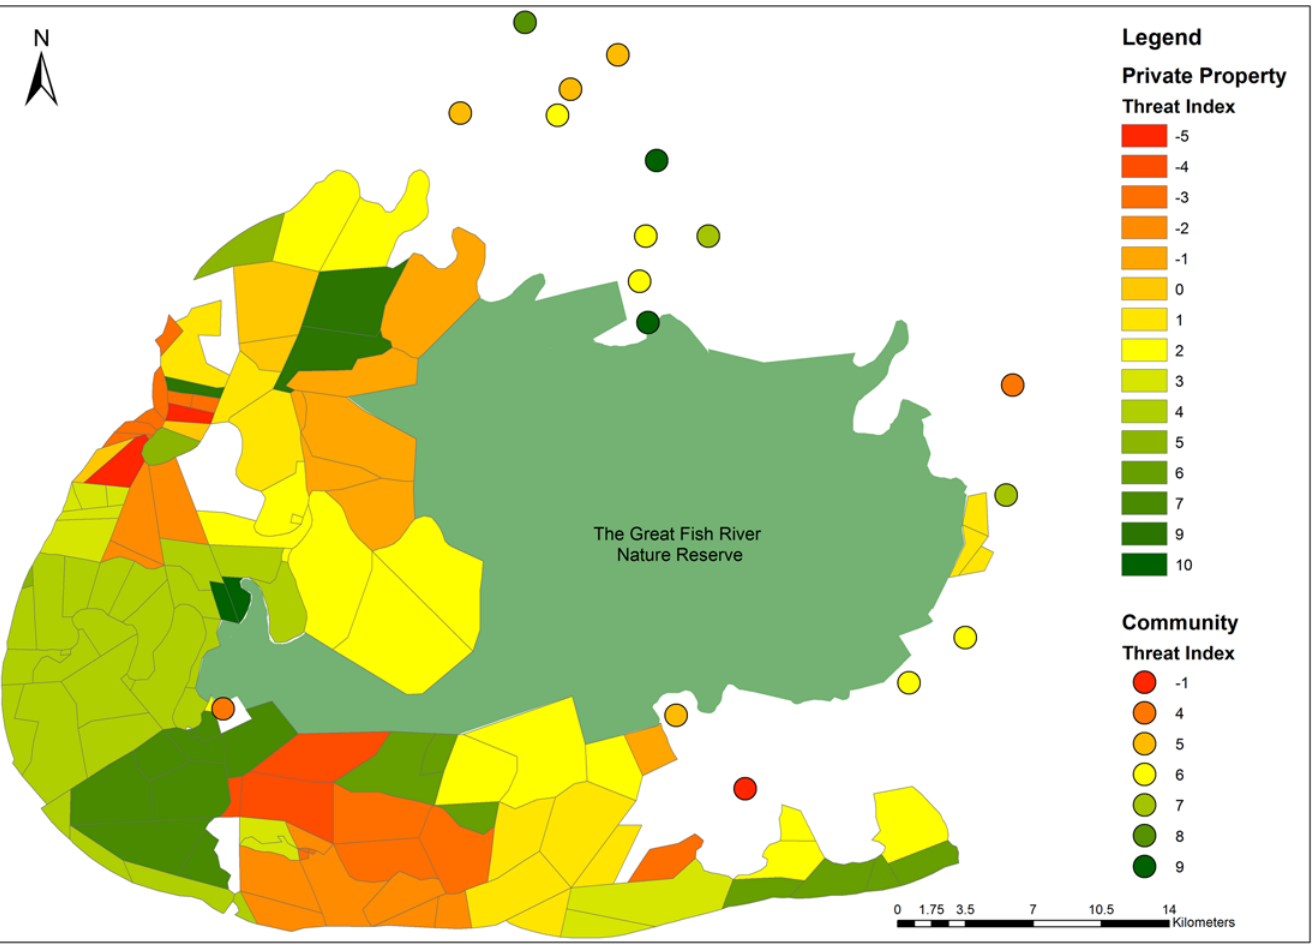
Fig 2. The threat index scores of the communal area (represented as an average index score of the respondents for each community) and private properties surrounding the Great Fish River Nature Reserve. (Reds and oranges indicate higher threat areas while darker greens indicate low threat